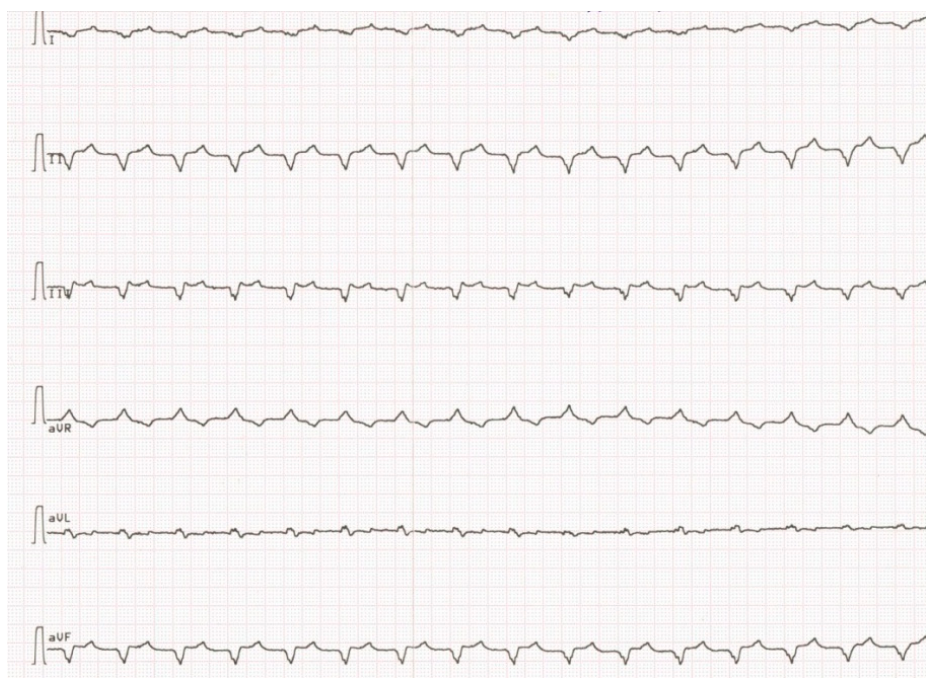
Figure 4. Paroxism of sustained ventricular tachycardia .